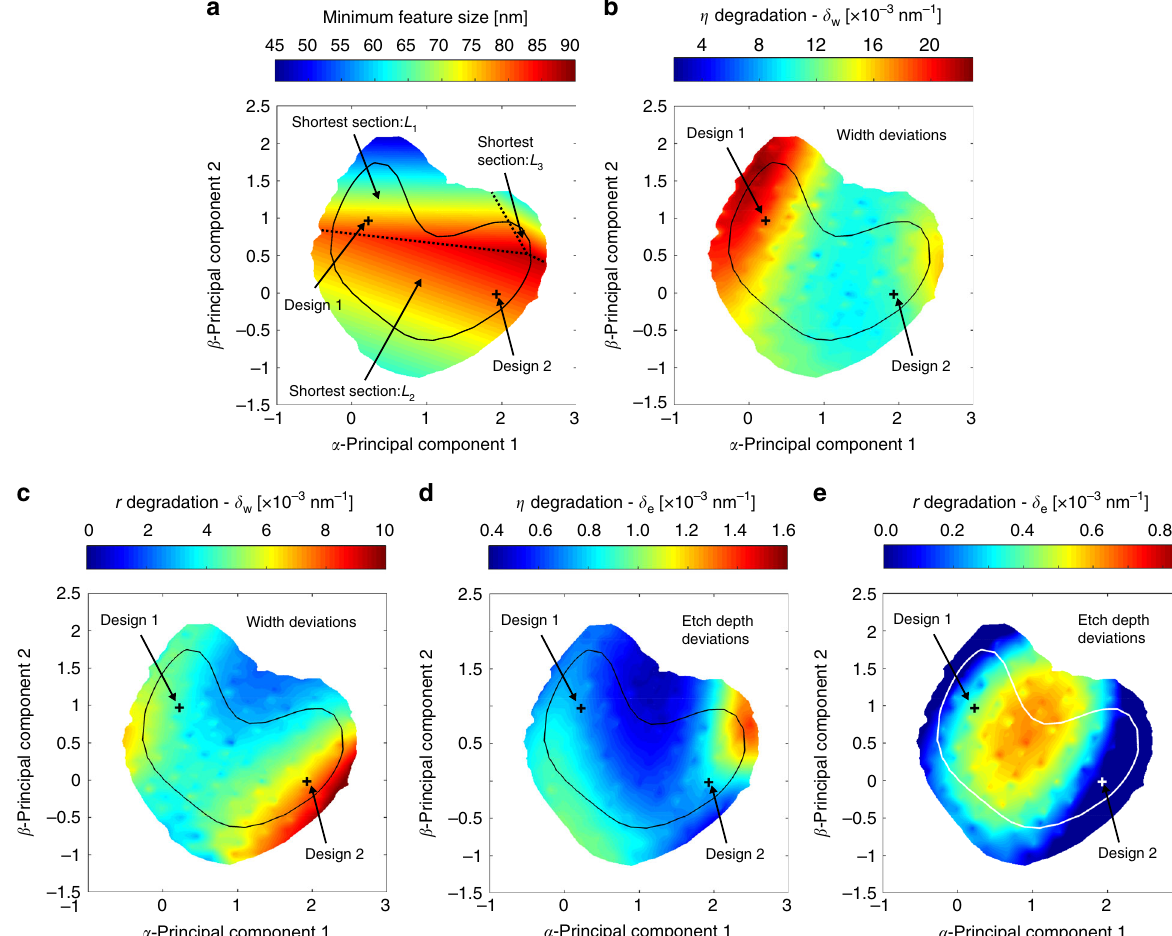
Fig. 4 Comprehensive device characterization. The α – β hyperplane is exploited to investigate additional performance criteria. To ease comparison with Fig. 3, in each map, the solid contour encloses the region of good designs ( η > 0.74) while the two crosses mark design 1 and 2. a Minimum feature size for the different designs. The map highlights also for which segment this minimum size occurs, identifying three areas (dashed black lines), where L 1 , L 2 , or L 3 is the shortest feature. Grating designs with minimum feature size greater than 88 nm do not exist. For almost the entire region of good designs, the minimum feature is either L 1 (e.g., for design 1) or L 2 (e.g., for design 2). b – e Sensitivity of the designs to b , c width deviations δ w of both shallow and deeply etched sections in the grating and d , e etch depth deviations δ e for the shallow-etched section. The maps show the value of the degradation derivative for b , d coupling ef fi ciency η and c , e back re fl ections r across the sub-space of good designs as de fi ned in the Methods section. Coupling ef fi ciency of design 1 is more sensitive to width deviations compared with design 2. The opposite occurs for back re fl ections, where design 2 has a higher sensitivity than design 1. Both coupling ef fi ciency and back re fl ection have a low sensitivity to etch depth variations within most of the region of